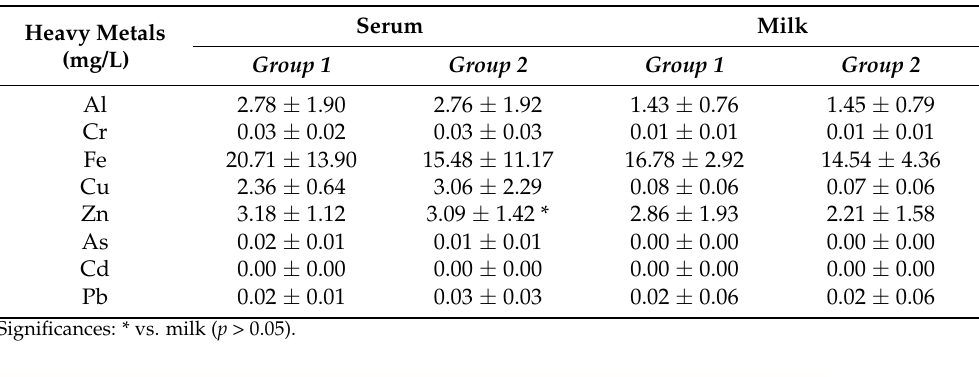
Table 2. Mean ± standard deviation (SD) of heavy metal concentrations measured in serum and milk samples obtained from 40 Friesian dairy cows housed in farm 1 at about 3.7 km form an industrial area (group 1) and 40 Friesian dairy cows housed in farm 2 at about 400 mt from a greenhouse and 6.0 km from a chemical fertilizer factory (group 2).